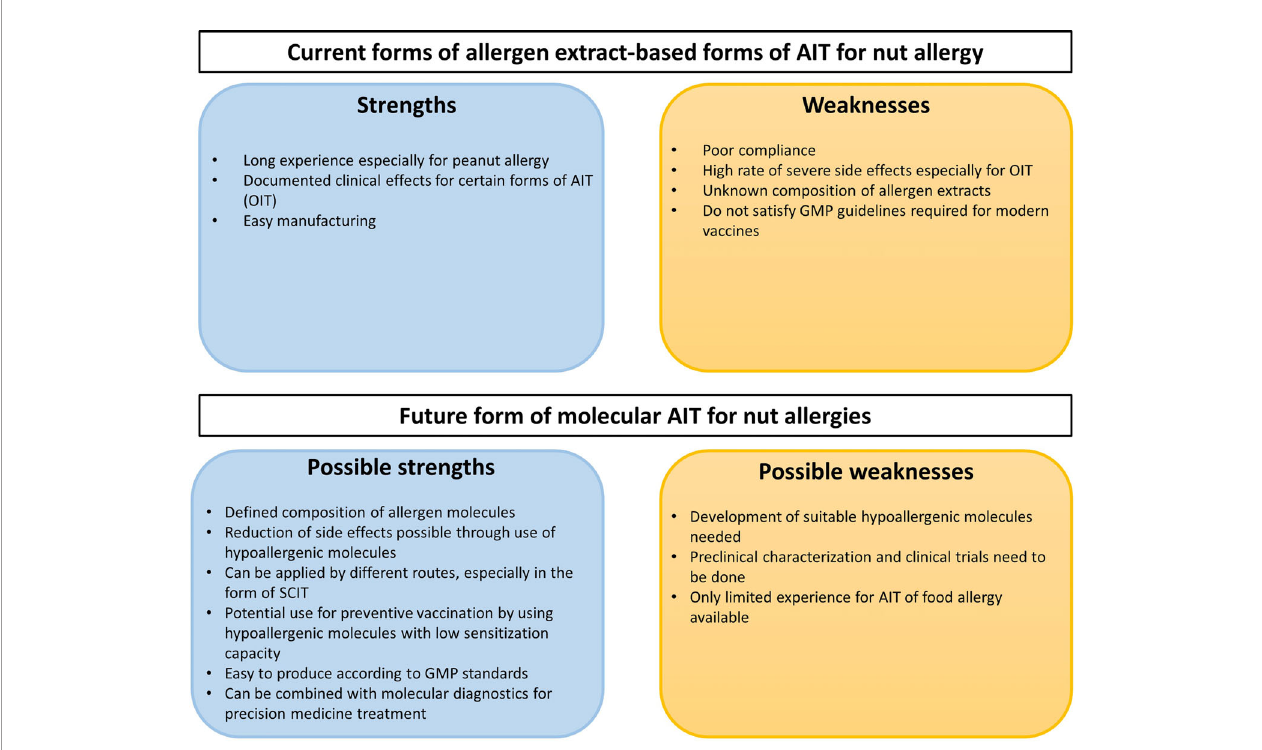
FIGURE 5 | SWOT analysis of existing allergen extract-based forms of AIT for nut allergy and future molecular AIT